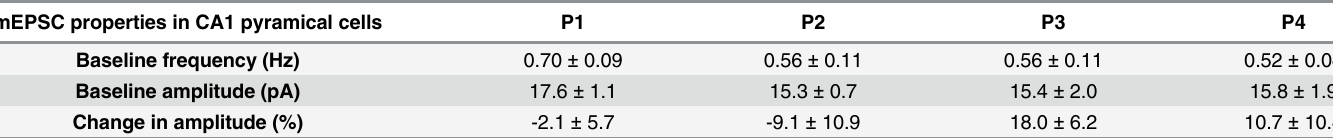
Table 1. Absolute baseline mEPSC frequency and amplitude ( ± SEM) recorded in CA1 pyramidal cells for each experimental group. Changes dur- ing each pulse of corticosterone (% relative to the corresponding baseline) are only shown with respect to the amplitude; for relative changes in mEPSC fre- quency we refer to Fig 1. Based on 6 cells for each experimental